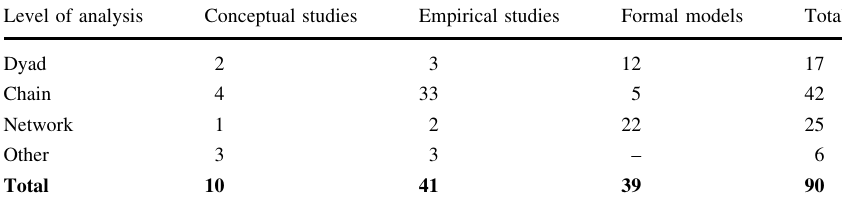
Table 8 Level of